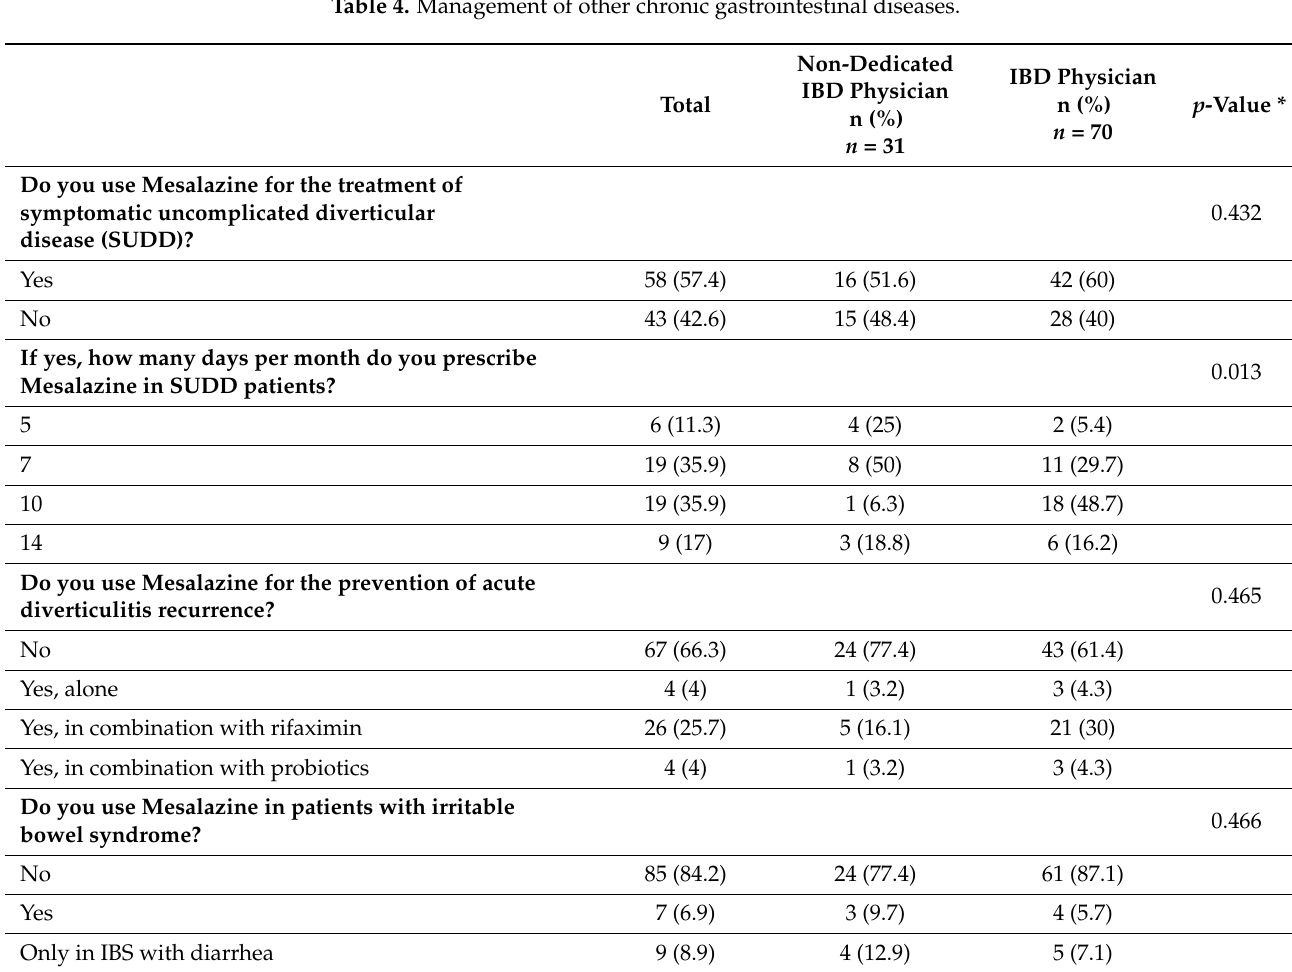
Table 4. Management of other chronic gastrointestinal